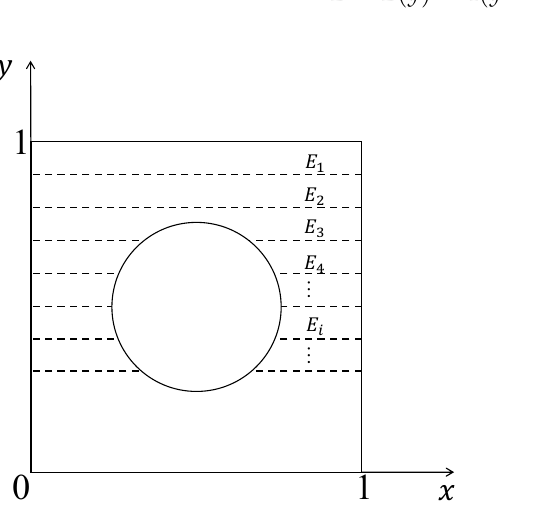
uniformly distributed in the 𝑦 direction. (cid:3041)